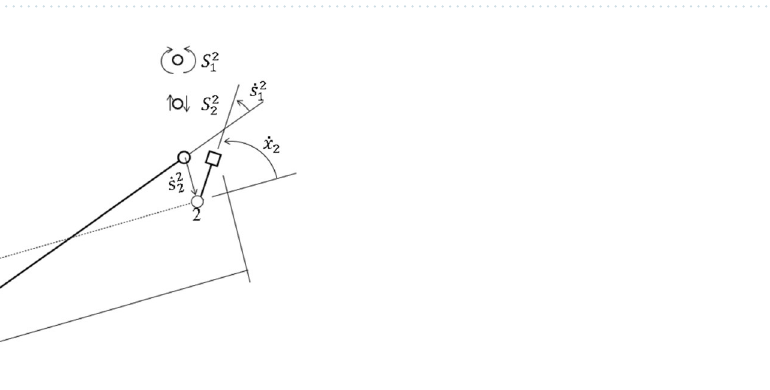
Figure 11. Dynamic bending moment evolution of flexure critical impulsively loaded simply supported beam.